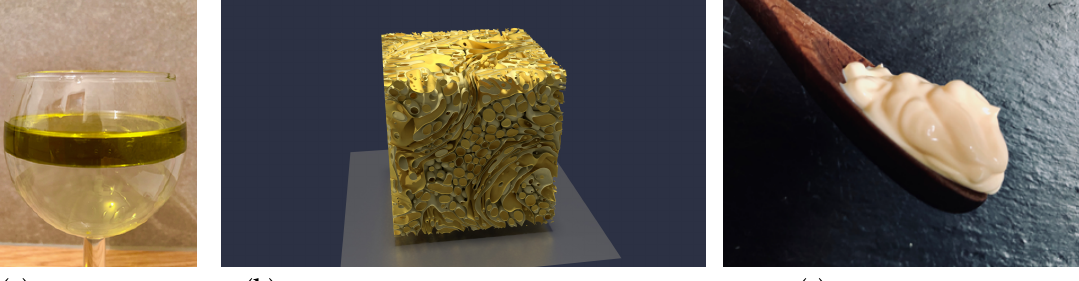
Figure 1. From two simple (Newtonian) fluids ( a ), to one complex (non-Newtonian) fluid ( c ). The production process of mayonnaise proceeds at home, as well as in food industry, via stirring of oil and water with addition of surfactants, in order to confer stability to the emulsion. With highly-optimized computer models, as the ones implemented in the LBE3D, we can study how to go from picture ( a ) to picture ( c ) using computer simulation, as illustrated from the screenshot in picture ( b